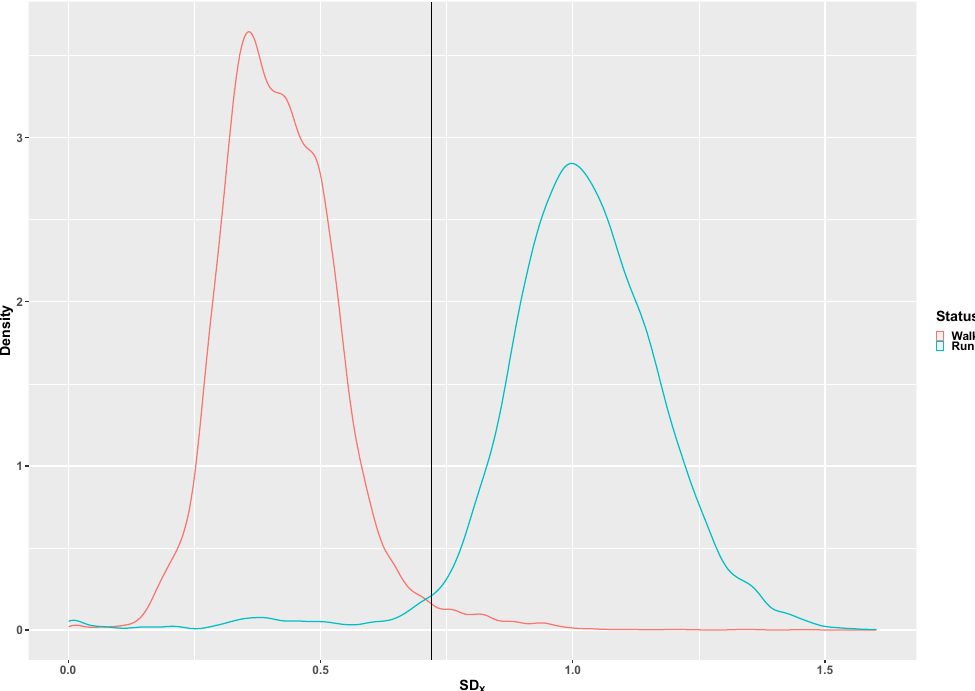
Figure 4. The pooled distribution of the SD X signal feature for walking (red curve) and running (green curve). The vertical line represents the original adult 0.72 g SD X threshold (Skotte et al. 2014).